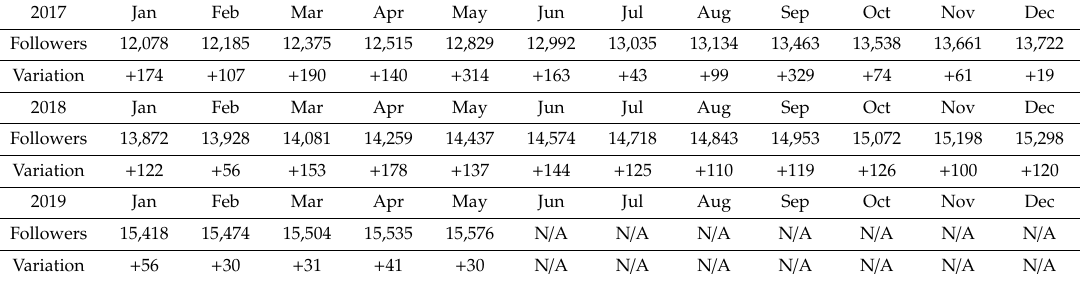
Source: Authors’ own